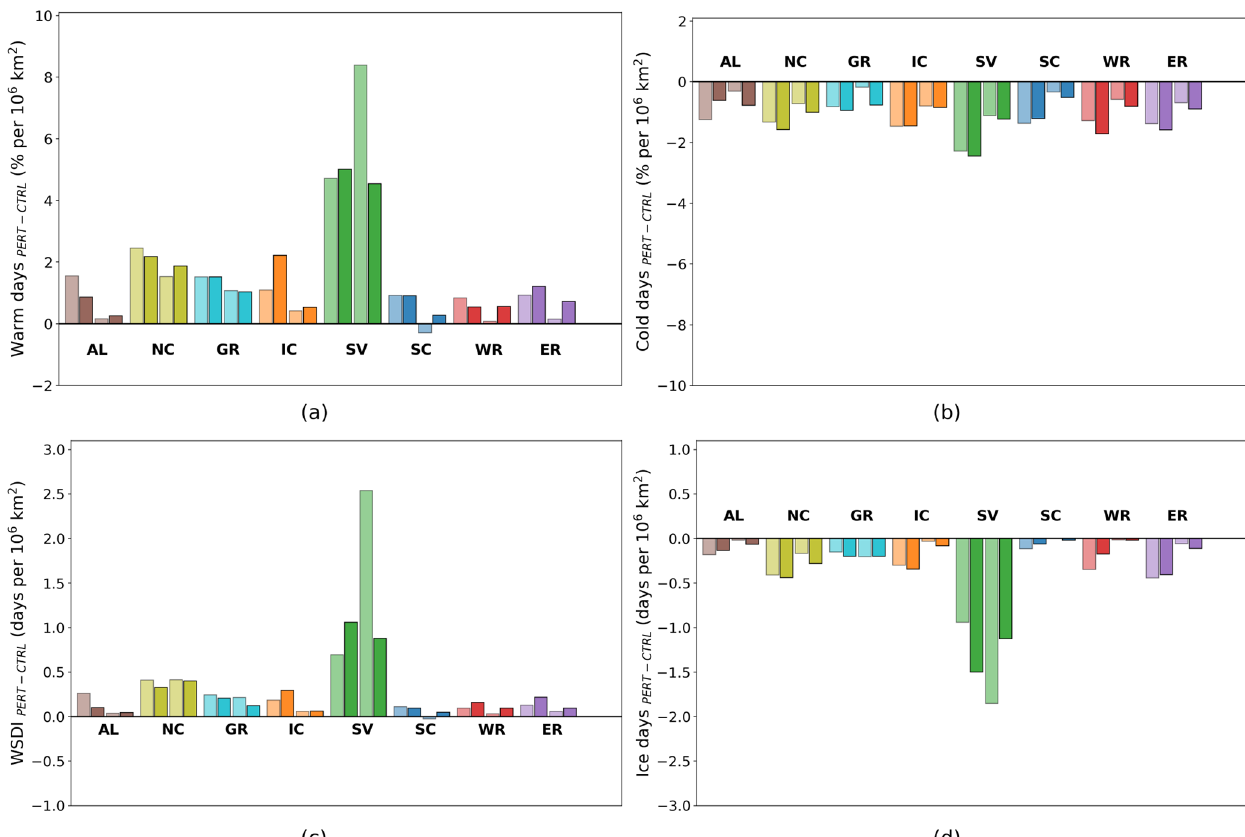
Figure 8. Ensemble mean changes (PERT − CTRL) per month averaged in summer (JAS) in warm days (a) , cold days (b) , warm spell duration index (c) and ice days (d) scaled by the amount of sea ice extent loss for the eight regions defined in Table 3 (Fig. 2) for ECMWF-LR (left light bar), ECMWF-HR (left dark bar), CNRM-LR (right light bar) and CNRM-HR (right dark